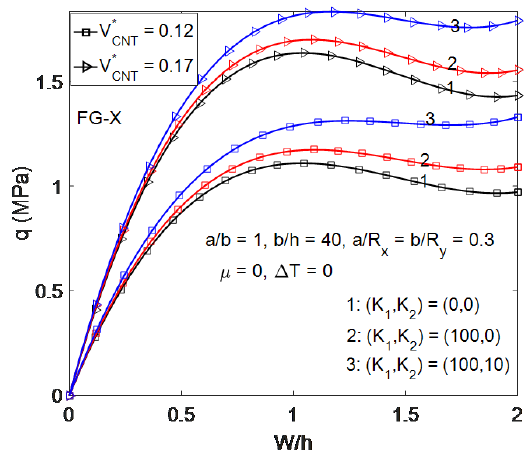
Fig. 11: Effects of elastic foundations on the nonlinear response of FG-CNTRC spherical panels under uniform external pressure with immovable edges.